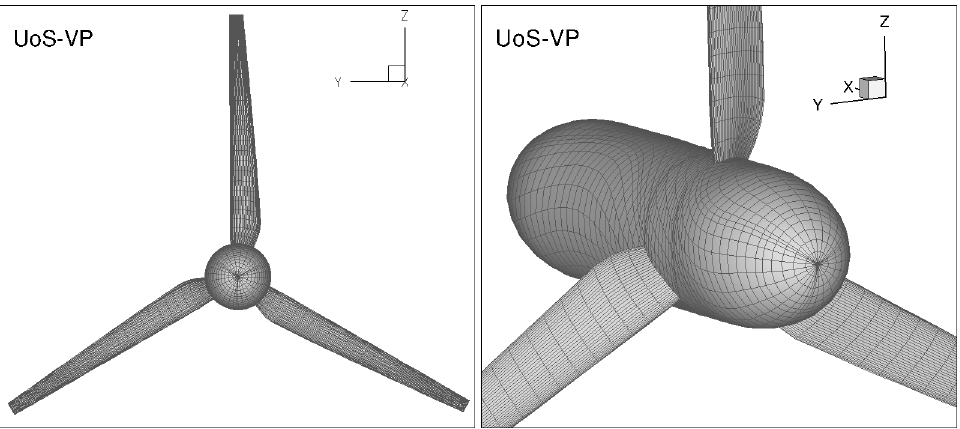
Figure 15. UoS-VP turbine. Three-dimensional model and computational grid for BIEM analysis. Left : front view; right : details of hub and blade roots.